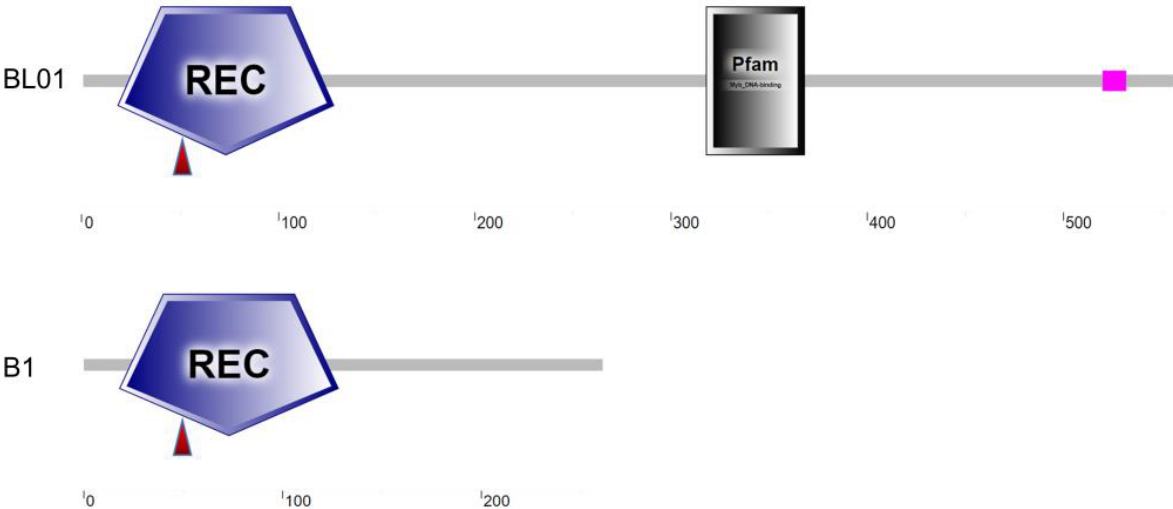
Figure 5. SmAPRR2 protein structure. The red triangle indicates one amino acid substitution occurring in the REC domain of BL01 and B1; the MYB-like DNA-binding domain is absent in B1.